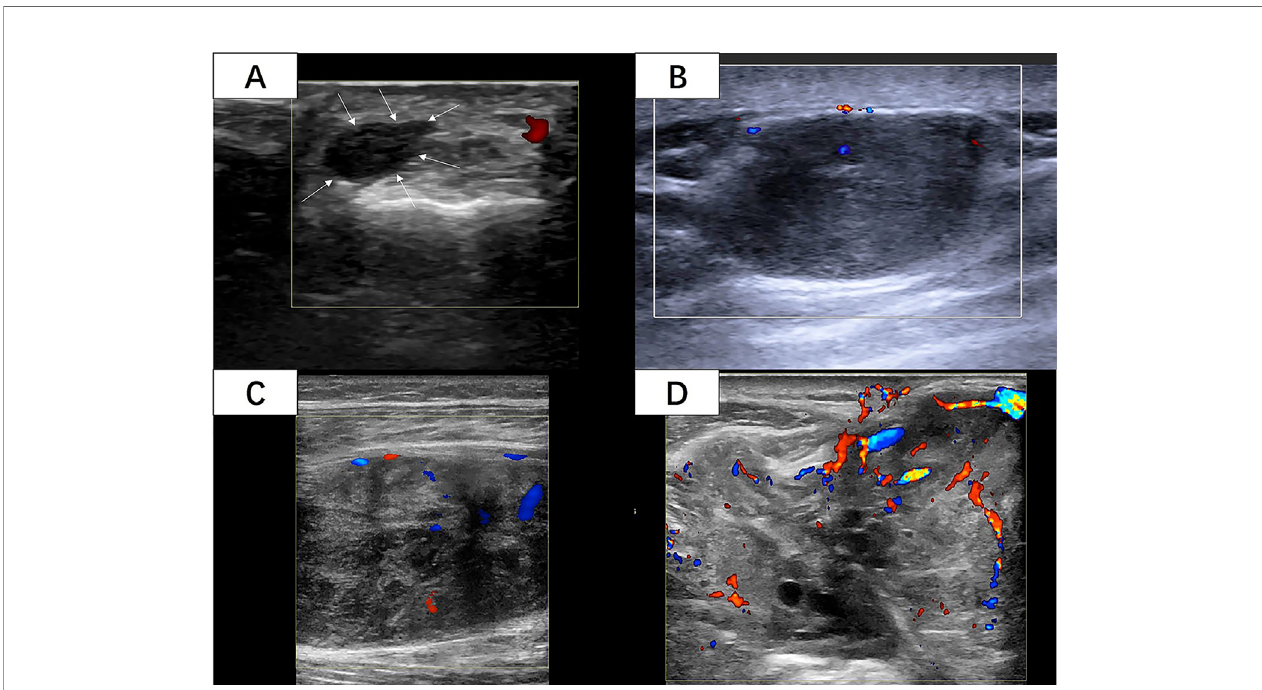
FIGURE 2 | (A) A 42-year-old woman with 6cm lesion with vascular density grade 0 with histological diagnosis of synovial sarcoma with Ki-67 LI of 5%. (White arrow: The margin of the lesion) (B) A 50-year-old woman with 27cm lesion with vascular density grade I with histological diagnosis of leiomyosarcoma with Ki-67 LI of 10%. (C) A 33-year-old woman with 73cm lesion with vascular density grade II with histological diagnosis of fi brosarcoma with Ki-67 LI of 10%. (D) A 70-year-old man with 86cm lesion with vascular density grade III with histological diagnosis of synovial sarcoma with Ki-67 LI of 60%. (Images were obtained from four different lesions included in our